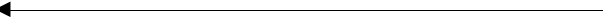
Fig. 1. An overview of the magnetic field and energetic particle conditions around the energetic particle burst on March 31, 1993 at 0137 UT. The top four panels show the magnetic field in GSM co- ordinates at 3 s resolution. The bottom 4 panels show the di(cid:128)erential energy fluxes of the energetic particle channels ED1 , E5 , E3 and M2 . For each channel we overplotted the fluxes of the sectors looking towards the Sun, with the adjacent sectors, two towards dawn and two dusk, as indicated on the right-hand-side of each panel. The solid vertical lines indicate the two time epochs 0142 UT and 0200 UT, when GEOTAIL leaves the south lobe and returns to it respectively. The two dashed vertical lines indicate the start (0144 UT) and the end times (0159 UT) of convection interval. The start time of the convection interval is coincident with the start of bipolar signature in the B z component. The time of Earthward edge of the bipolar signature encountered is marked by the dashed-dotted vertical line (0152 UT).